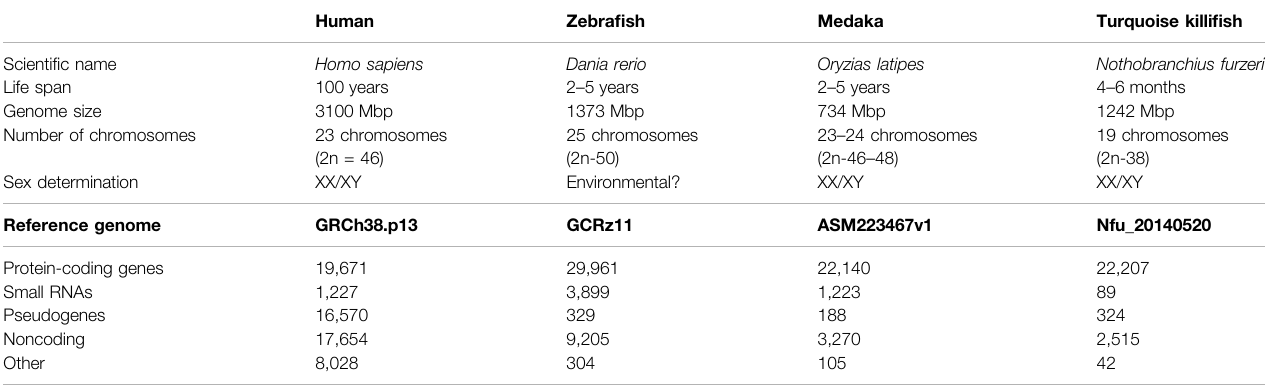
TABLE 1 | Lifespans and genomic characteristics of humans, zebra fi sh, medaka, and turquoise killi fi sh.